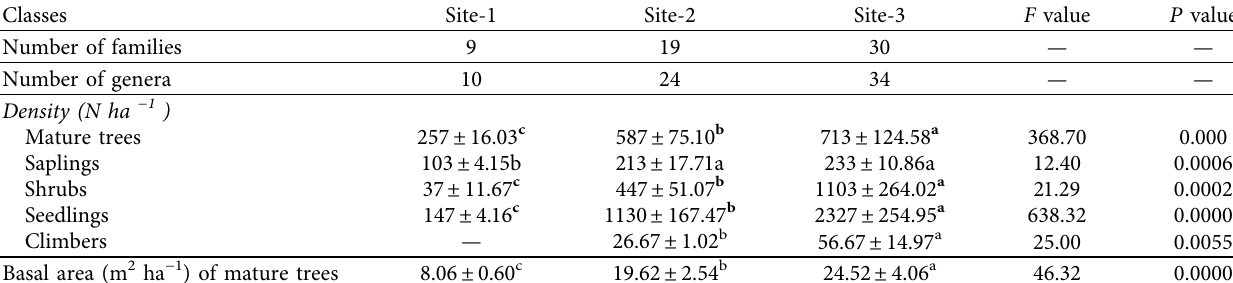
Table 5: Phytosociological analysis of forest species in three distant sites of the study area.